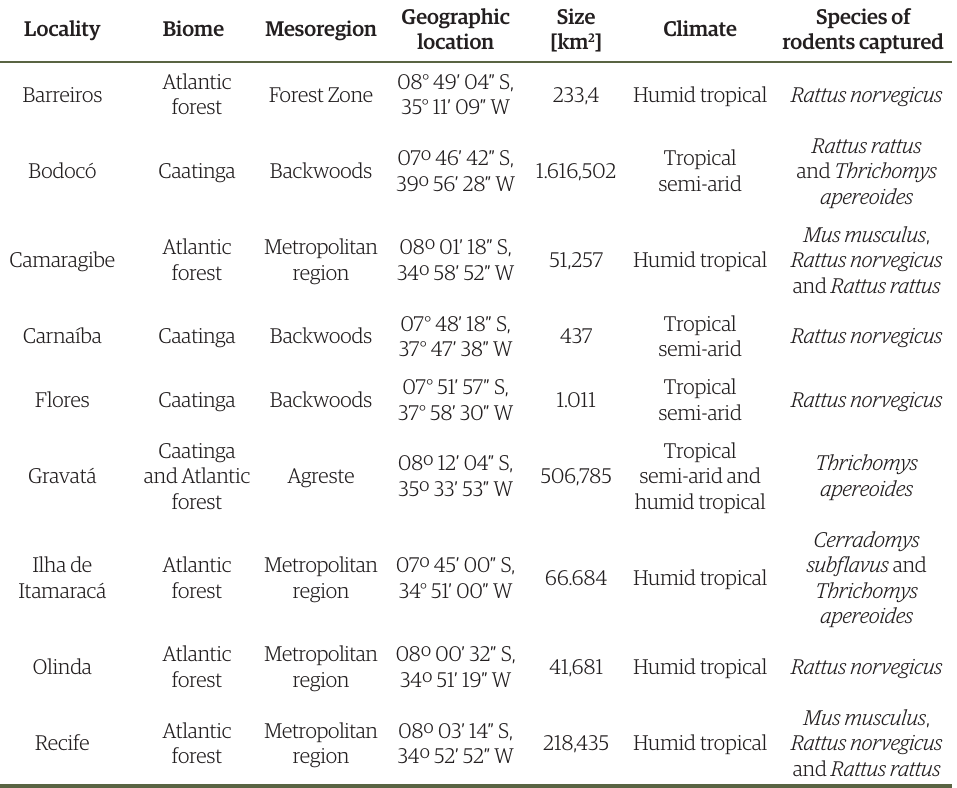
Table 1. Localities per landscape type, mesoregion, their coordinates, sizes, climate and the species of rodents captured per locality in Pernambuco,